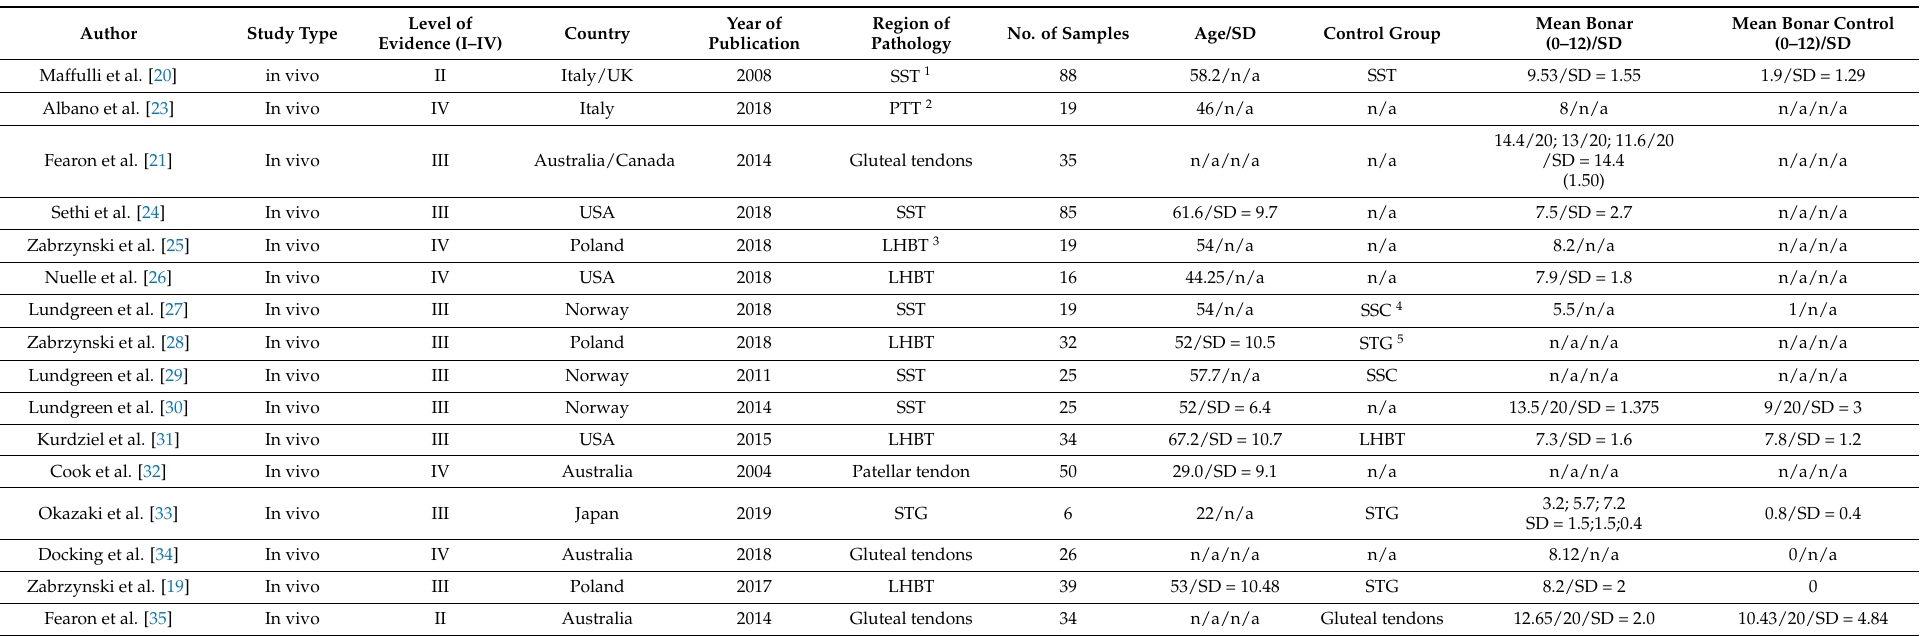
Table 2. Included studies of the Bonar score application in various tendons localizations. Demographic